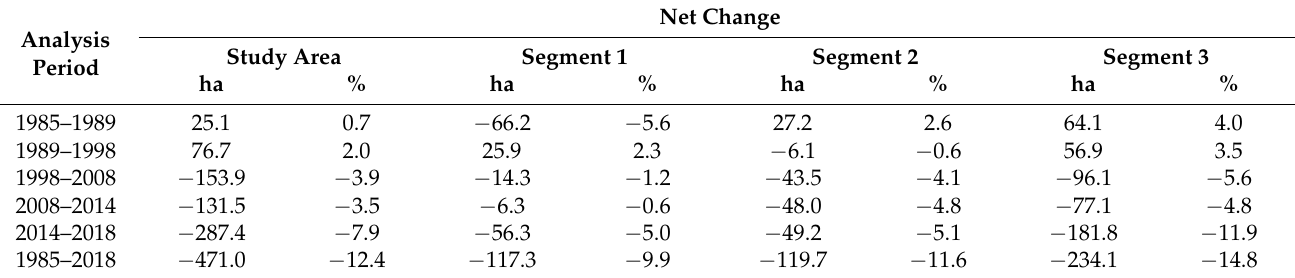
Table A1. Net change in active areas in each analyzed